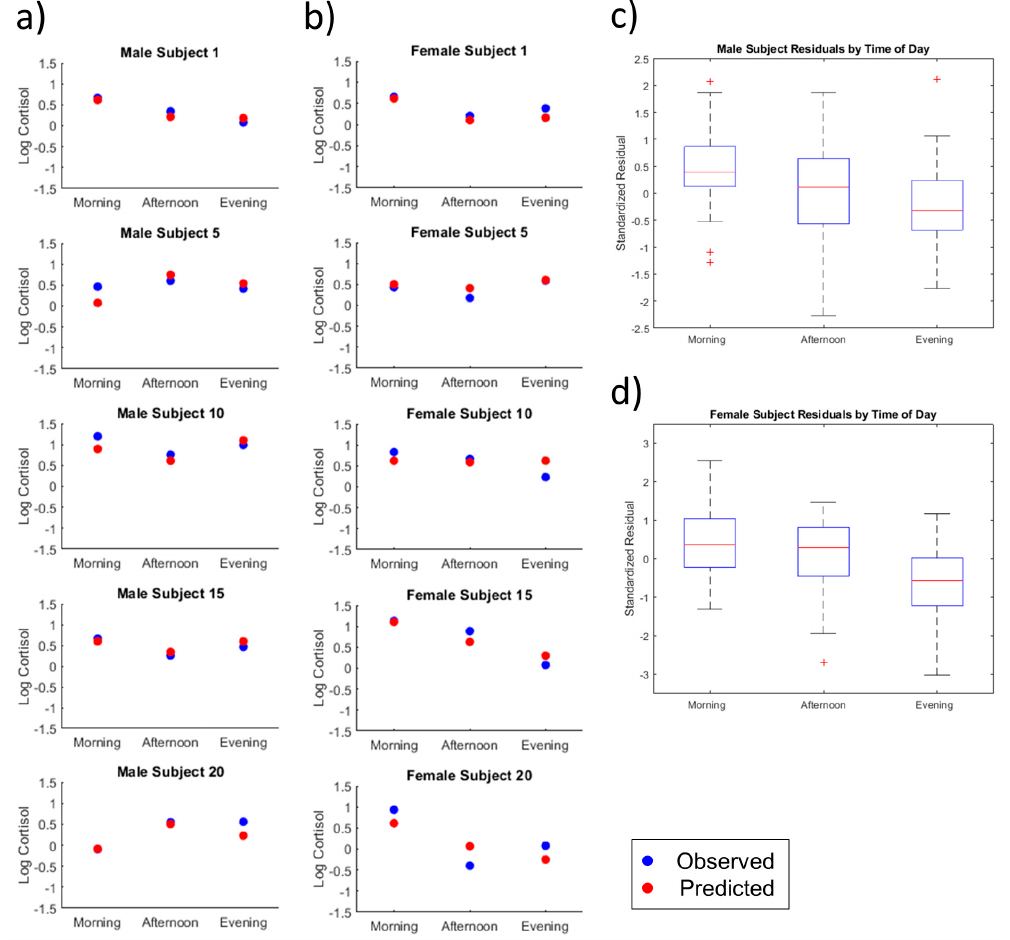
Figure 2. Individual subject analysis by time of day. ( a ) Observed and predicted total free urinary cortisol for five male subjects; ( b ) observed and predicted total free urinary cortisol for five female subjects; ( c ) the boxplot of male subject standardized residuals by time of day; ( d ) the boxplot of female subject standardized residuals by time of day.